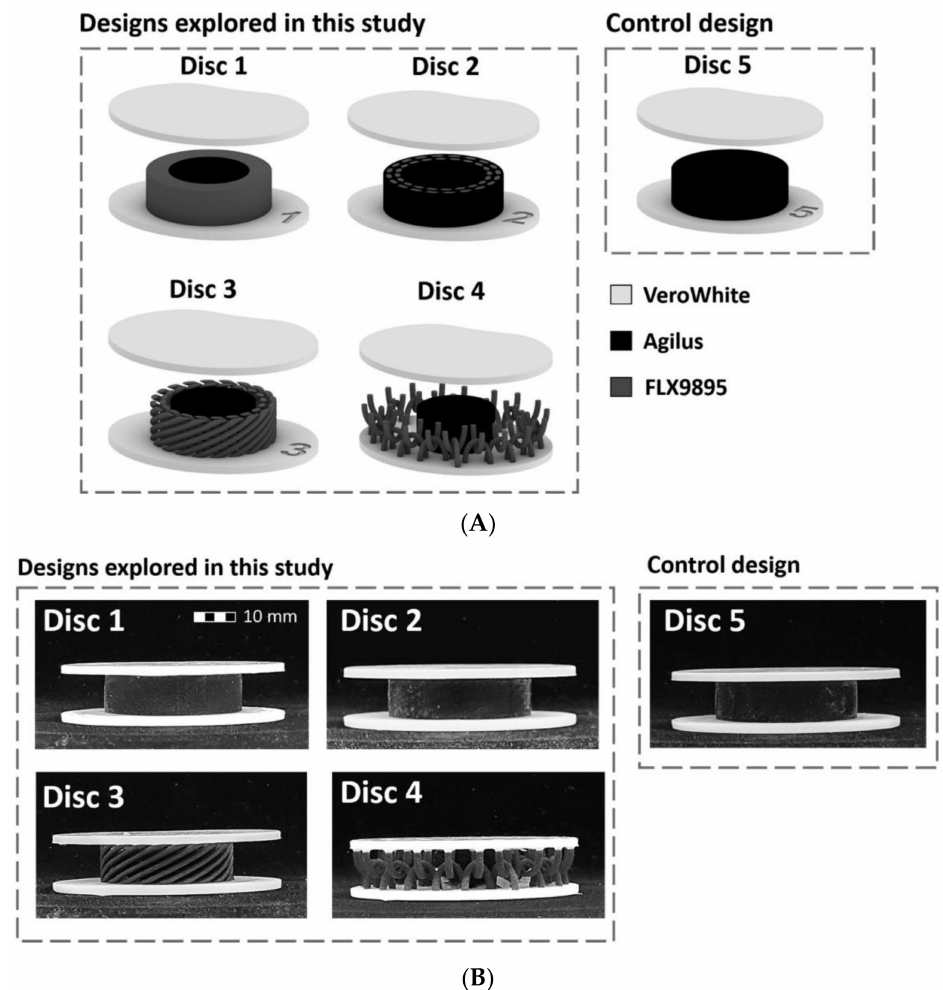
Figure 4. ( A ) Schematic representations and ( B ) 3D-printed specimens of the artificial IVDs designed by Yu et al. Reprinted from an open access source